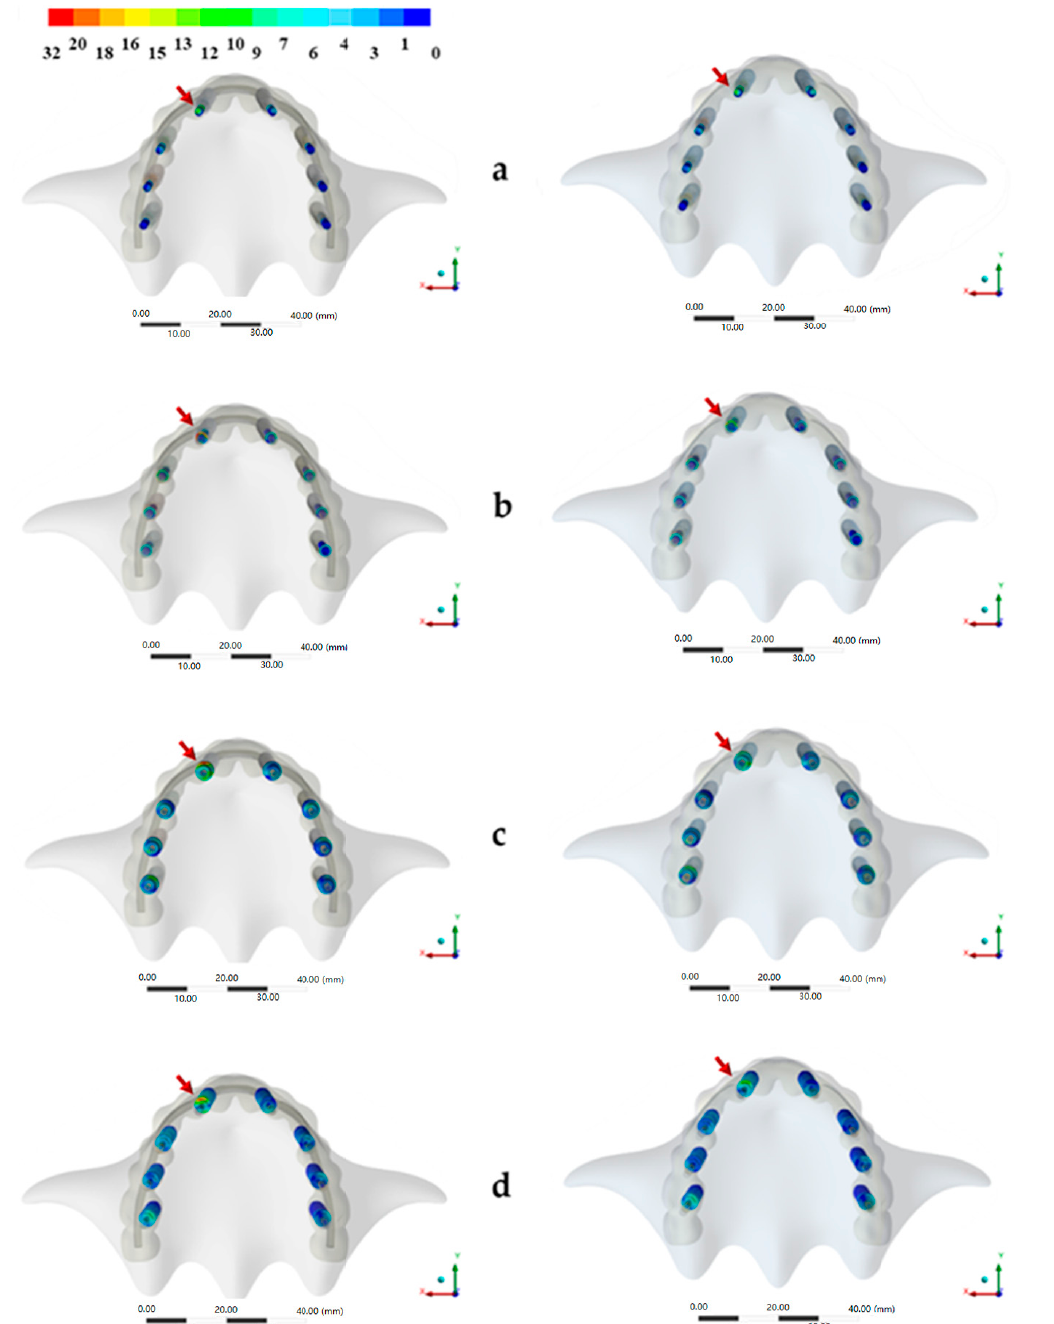
Figure 4. ( a – d ) Maps of von Mises stress distribution results in the conventional design (Left) andintheprosthesisexperimentaldesign(Right). ( a )Prostheticscrew, ( b )Abutmentscrew, ( c )Abutment and ( d ) Implants. The red arrows indicate the areas with more concentrated